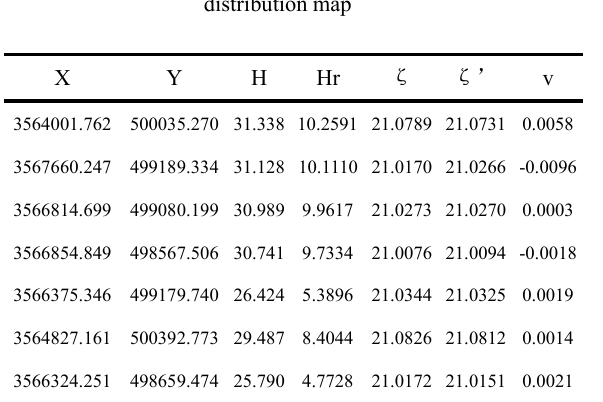
Table 5 Fitting elevation anomalies and residuals